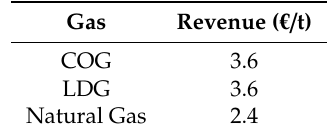
Table 8. Revenue for steam